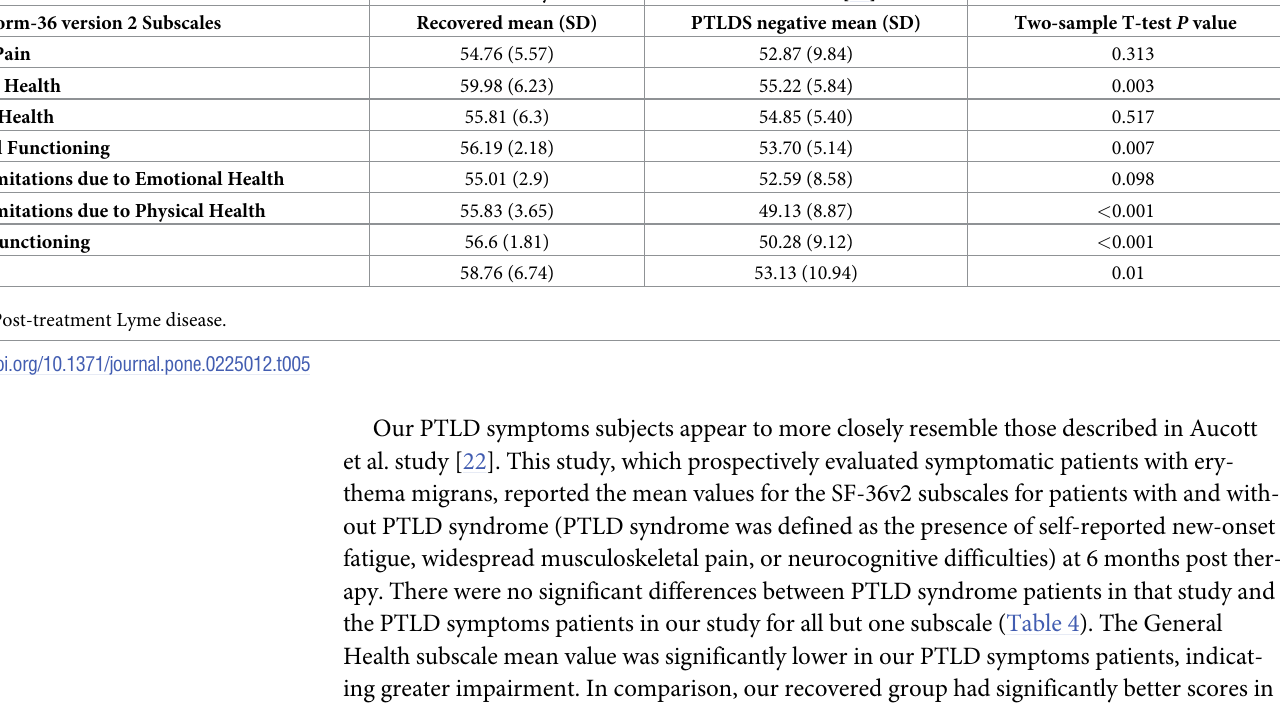
Table 5. Comparison of the Short Form-36 Version 2 Subscales for patients without post-treatment Lyme disease symptoms. This study Aucott et al.